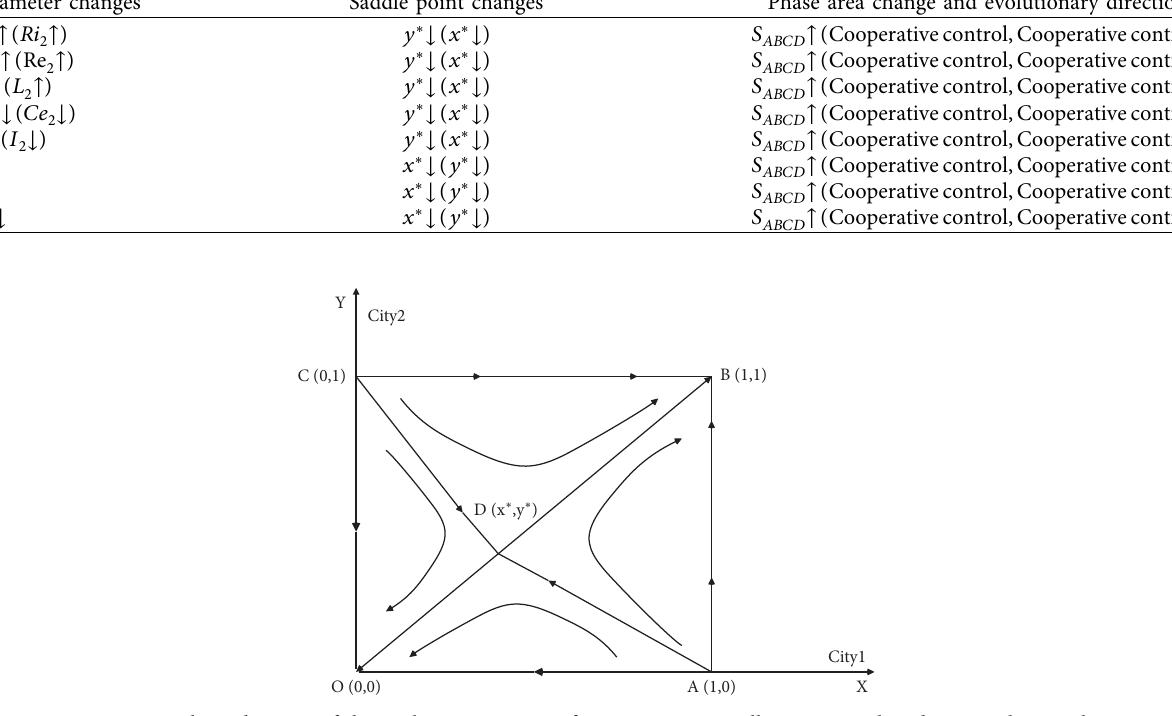
Figure 7: Phase diagram of the evolutionary game of cooperative air pollution control under central control. Table 5: Effect of parameter changes on evolutionary games with